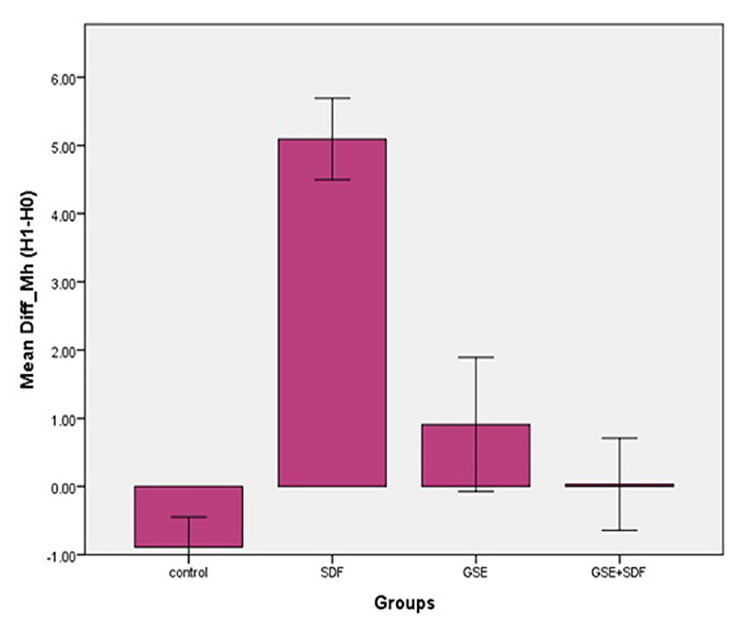
Fig 2. Elastic modulus of the study